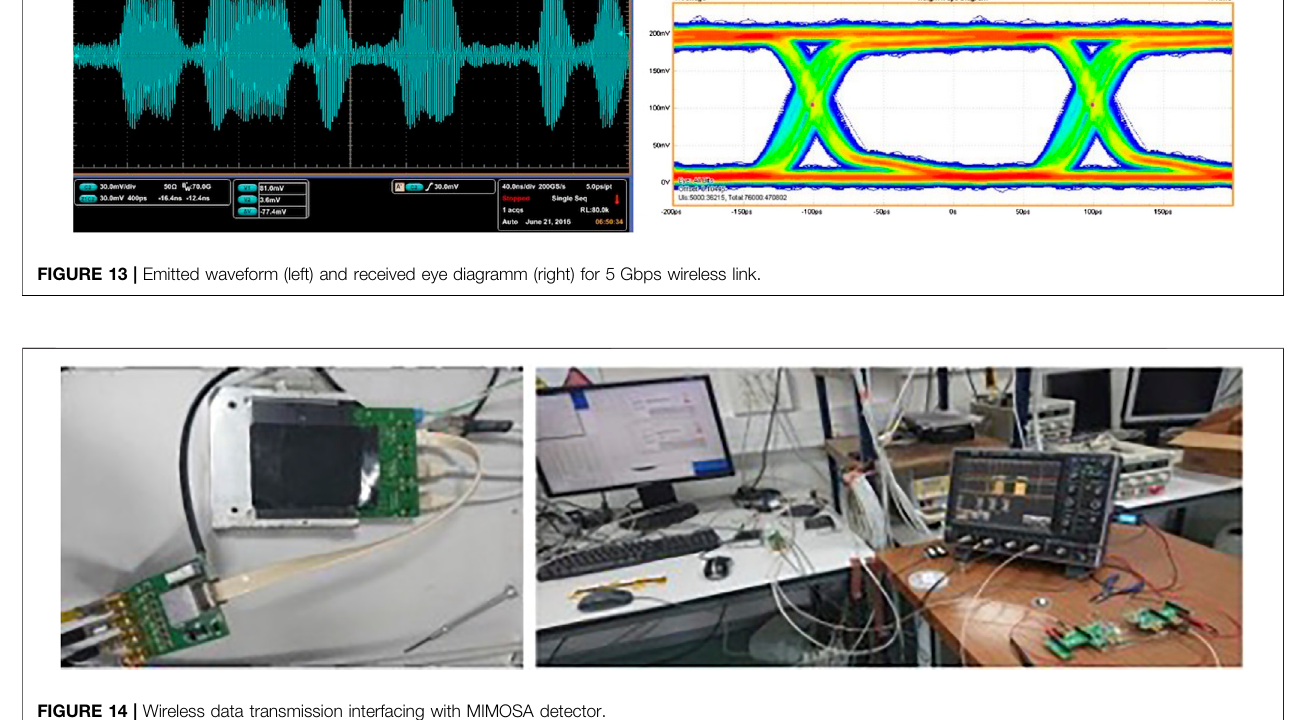
FIGURE 14 | Wireless data transmission interfacing with MIMOSA detector.